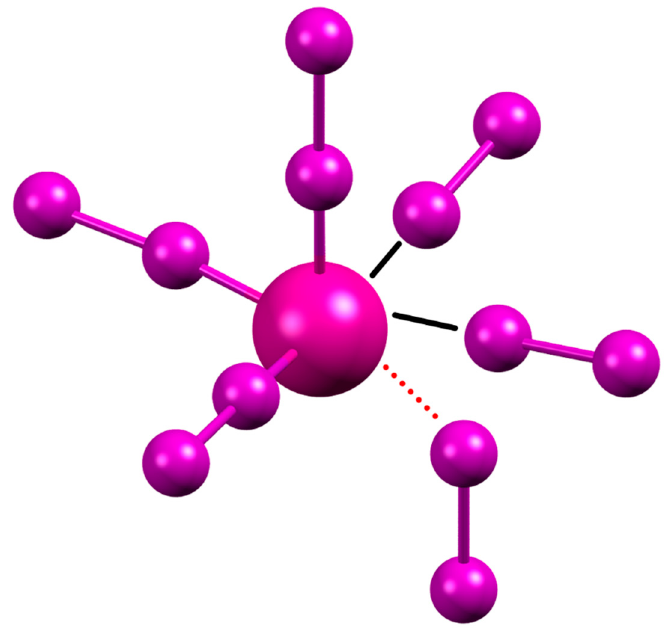
Figure 8. I ··· I contacts found among the central atom of I 7 − B (highlighted in purple) and neighboring heptaiodides. Short secondary bonds are found linear according to σ -hole type interactions (black solid lines), longer contacts do not respect such geometry (red dotted line).